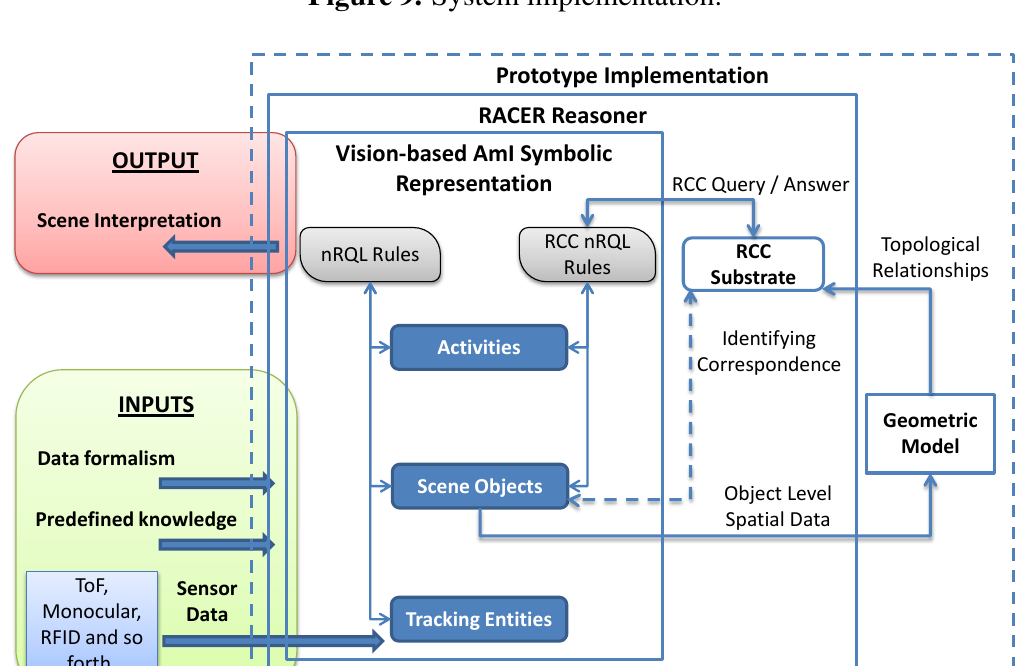
Figure 9. System